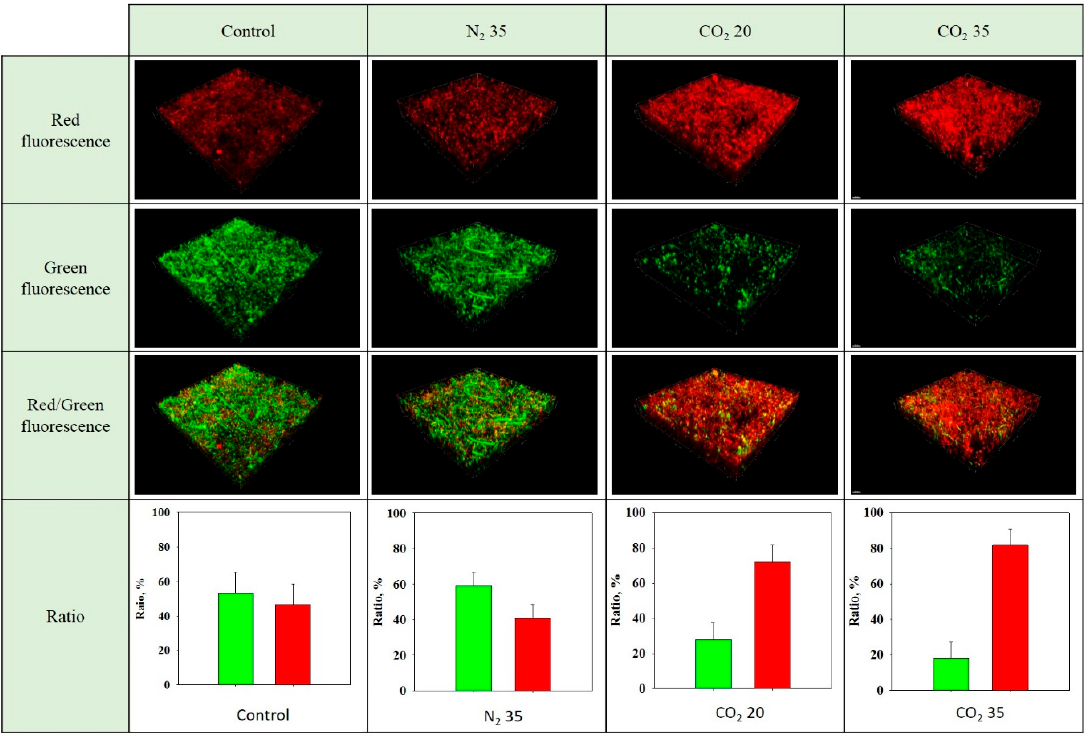
Figure 5. CLSM images of sludge stained by a live / dead Baclight TM bacterial staining kit (Invitrogen TM , Waltham, MA, USA) and the ratio of green- and red-colored portions in the sludge through the image analysis.